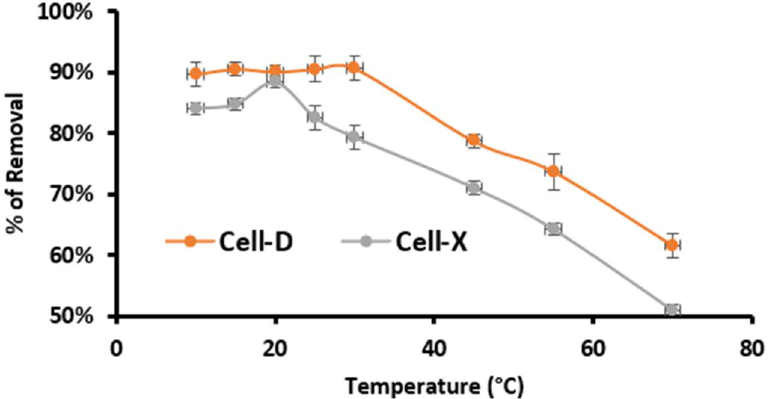
Figure 7. Effect of temperature on adsorption efficiency of Cell-X and Cell-D. (Dosage: 10 mg, volume: 10 mL, pH: 6 and 8 for Cell-X and Cell-D, respectively).